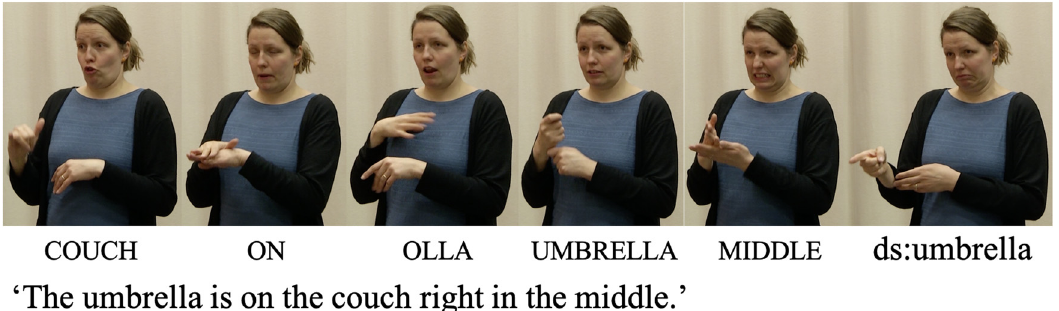
Figure 16: An example of a sequential strategy with an adposition sign and a known Figure entity.